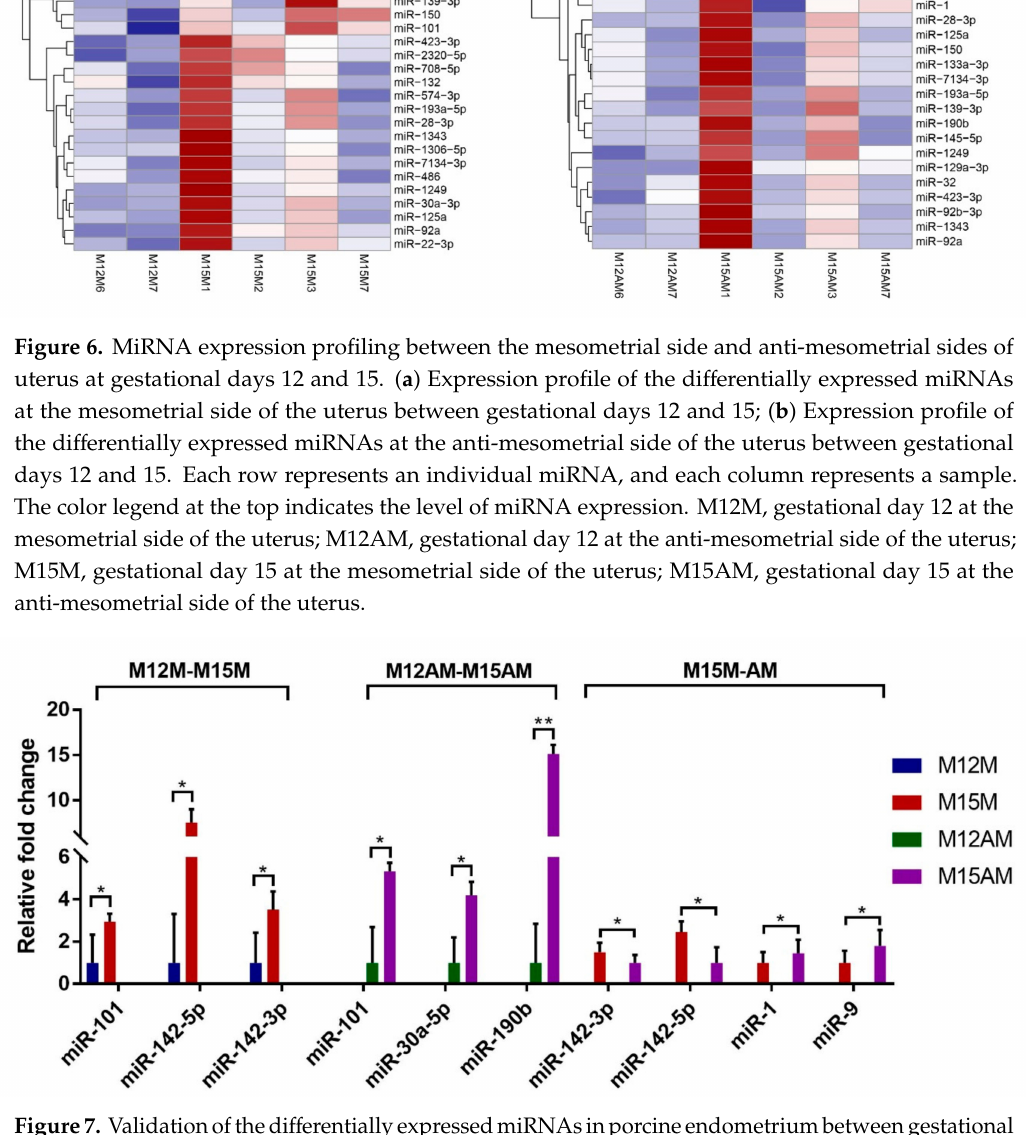
Figure7. Validationofthedi ff erentiallyexpressedmiRNAsinporcineendometriumbetweengestational days 12 and 15. The error bars show the SD. The p -value was calculated using the t -test. * p < 0.05; ** p < 0.01. M12M, gestational day 12 at the mesometrial side of the uterus; M12AM, gestational day 12 at the anti-mesometrial side of the uterus; M15M, gestational day 15 at the mesometrial side of the uterus; M15AM, gestational day 15 at the anti-mesometrial side of the